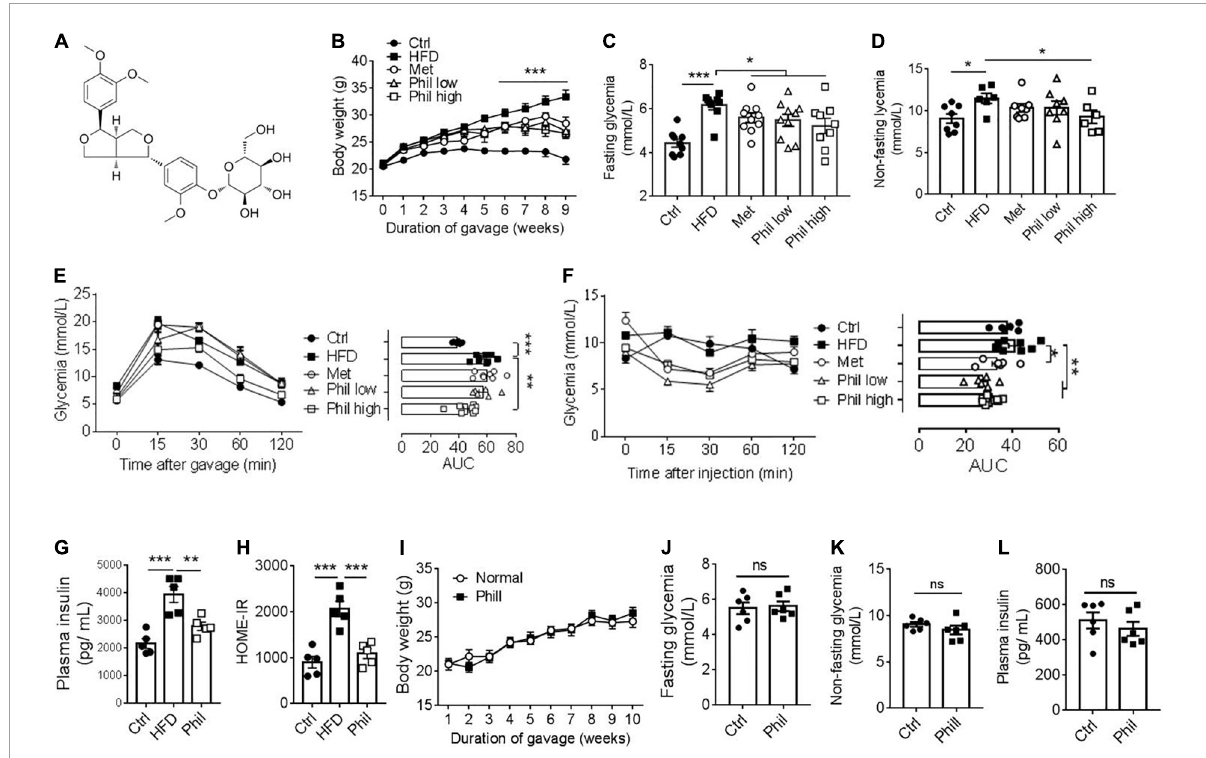
FIGURE2 Phillyrin treatment improves obesity-related metabolic disorders. (A) Diagram of the chemical structure of Phillyrin. (B) Body weight of mice treated preventatively with Phillyrin at 25 mg and 50 mg per kg body weight, 1 mg per kg body weight metformin (Met) or vehicle control. N = 6–9 per group. Levels of fasting (C) and non-fasting (D) glycemia in mice. N = 6–9 per group. (E) Oral glucose tolerance test determined after 2 months of drug intervention by gavage of 2 g per kg body weight of glucose, and (F) insulin tolerance test in mice by i.p. injection of 0.05 U per kg body weight of insulin. N = 6–9 per group. Area under the curve (AUC) was calculated using GraphPad Prism software. (G) Plasma level of insulin and (H) HOME-IR index in HFD-fed mice treated with or without Phillyrin at 25 mg per kg body weight. N = 4–5 per group. (I–L) Four weeks old male C57BL/6J mice treated with or without Phillyrin (25 mg/kg) for 10 weeks. (I) Body weight of mice. N = 6 per group. Levels of fasting (J) and non-fasting (K) glycemia in mice. N = 6 per group. (L) Plasma level of insulin. N = 6 per group. All data in the figure are